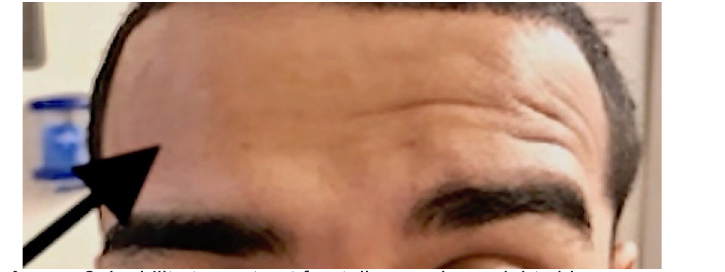
Image 2. Inability to contract frontalis muscle on right side.